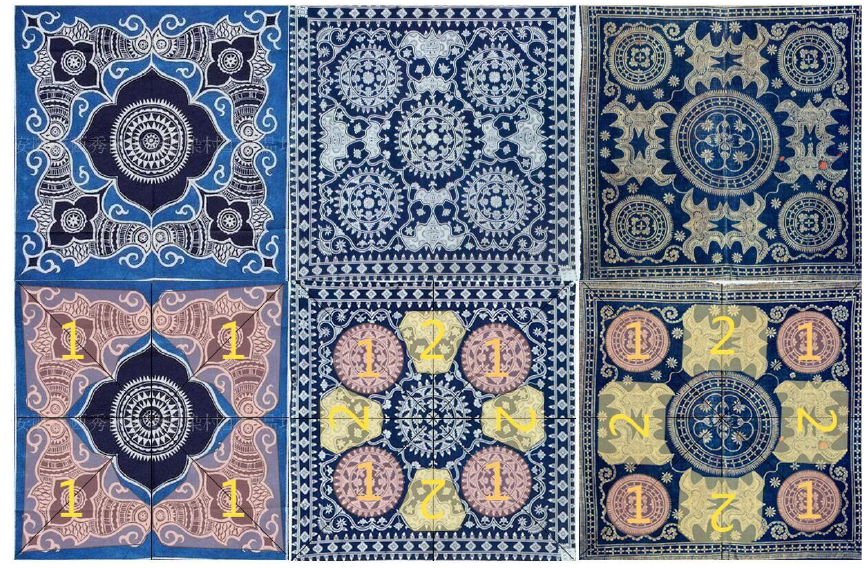
Figure 1. Traditional batik.